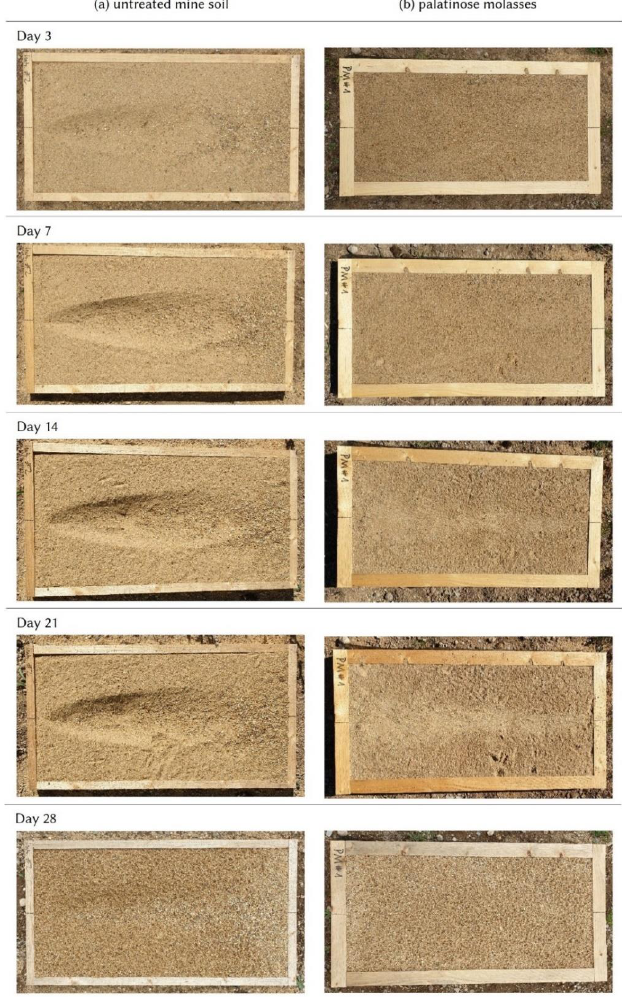
Figure 7. Photographic images of soil surfaces observed on day 3, 7, 14, 21, and 28 after the dust suppressants were applied: ( a ) untreated mine soil, and ( b ) mine soil treated with palatinose molas- ses. The size of each plot is 0.7 m × 0.4 m.